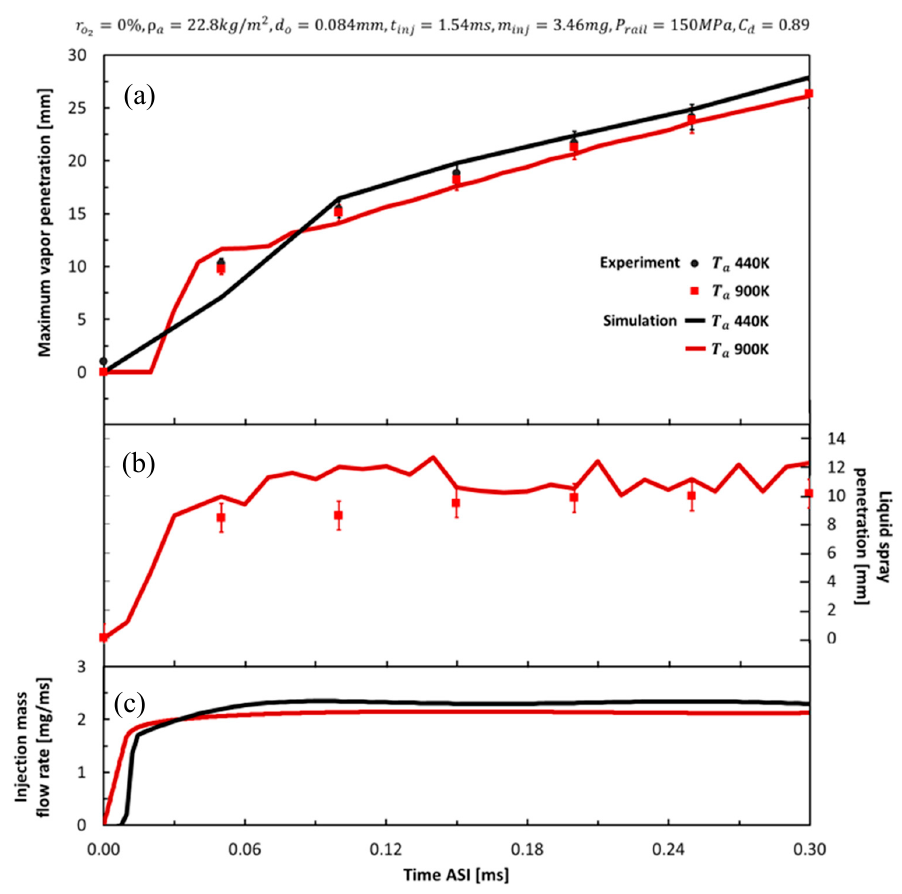
Figure 5. Comparison of the initial spray penetration (0.0–0.3 ms) of the experimental result [23] and the simulation result under different ambient temperatures. ( a ) Maximum vapor penetration, ( b ) liquid spray penetration and ( c ) injection mass flow rate.